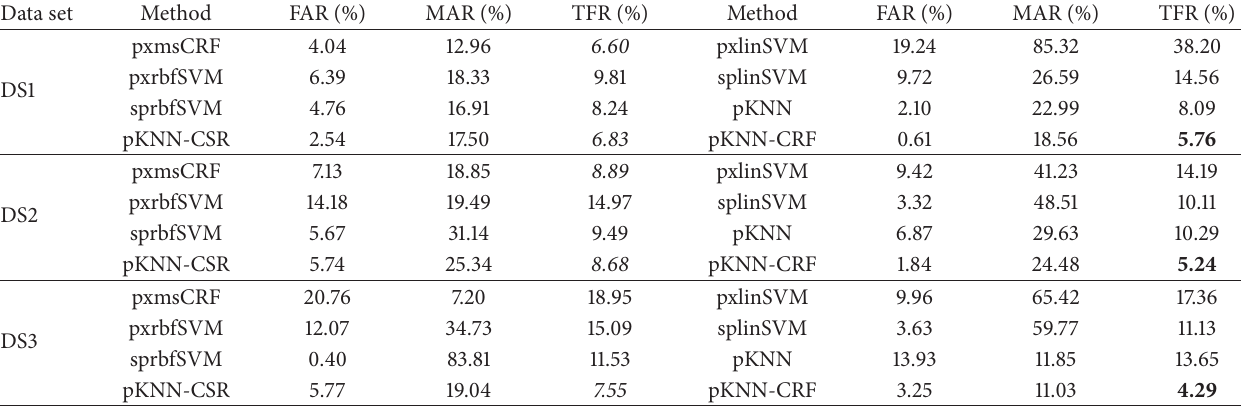
Figure 7: The monoscale and multiscale results on three data sets: DS1, DS2, and DS3 (from up to down). Table 1: Performance comparison of different CD methods. The bold value is the best and the italic one is the second. Data